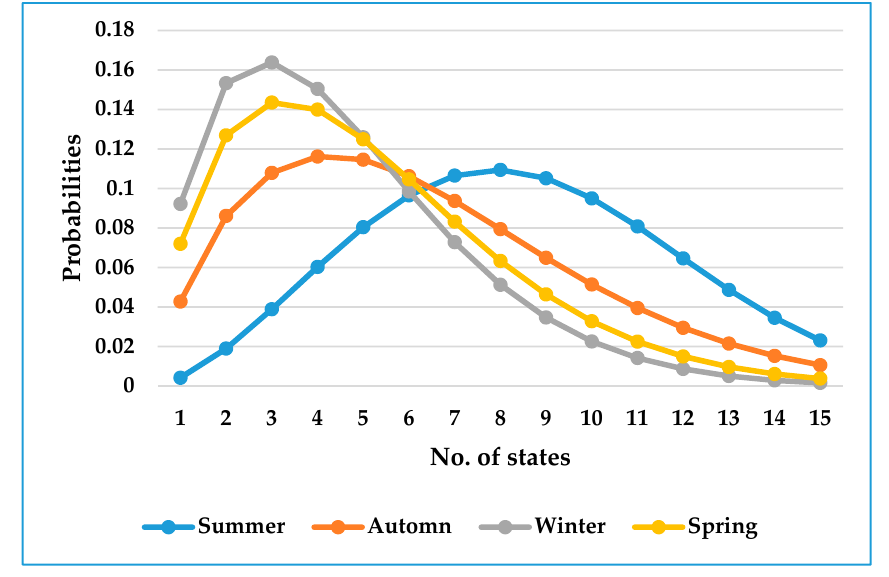
Figure 3. Seasonal time varying load profile values for each hour.